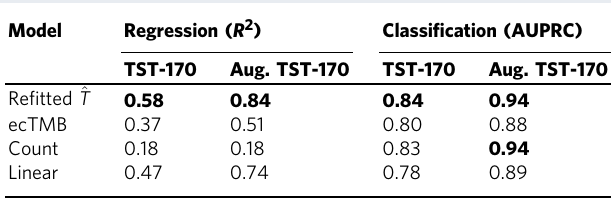
Table 1 Predictive performance of models on